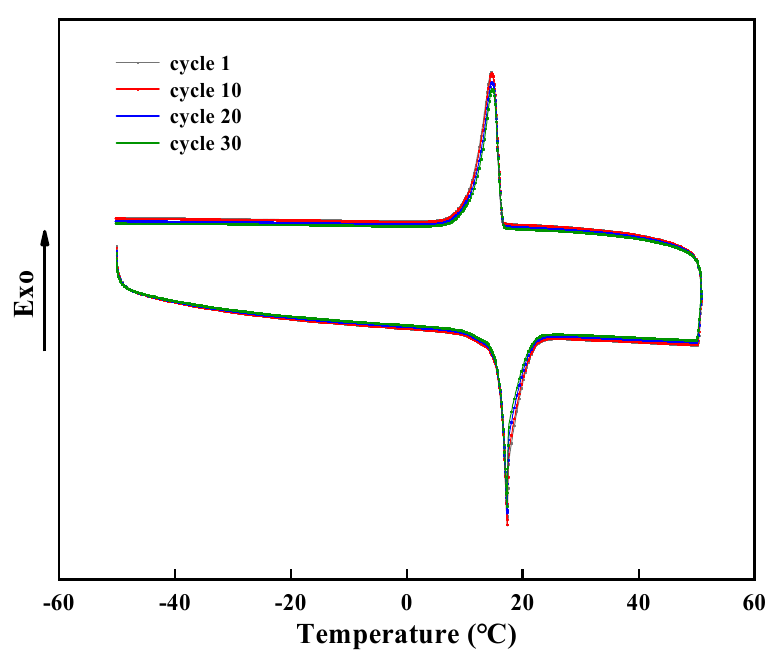
Figure 10. DSC spectra of different thermal cycles.